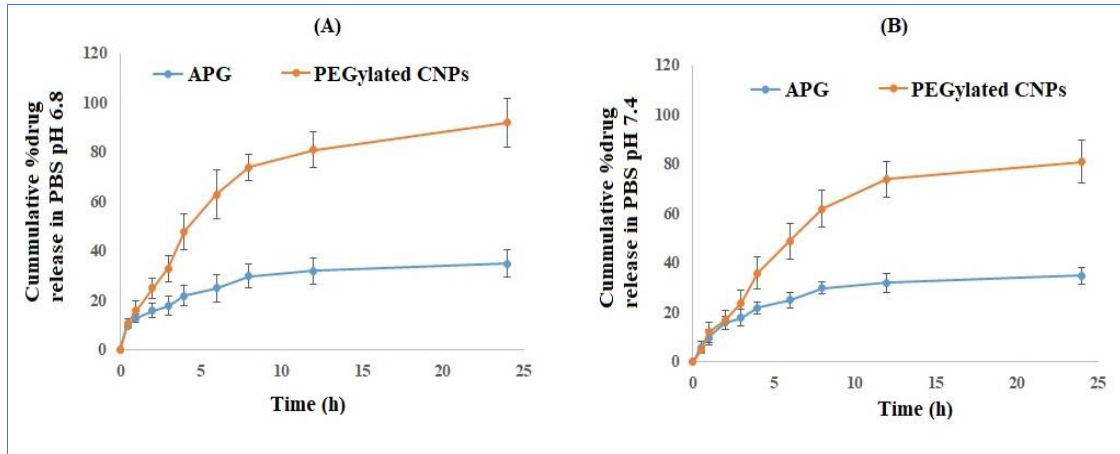
Figure 6. In vitro drug release profile of the optimized APG-PEGylated CNPs in ( A ) pH 6.8 and ( B ) pH 7.4 phosphate